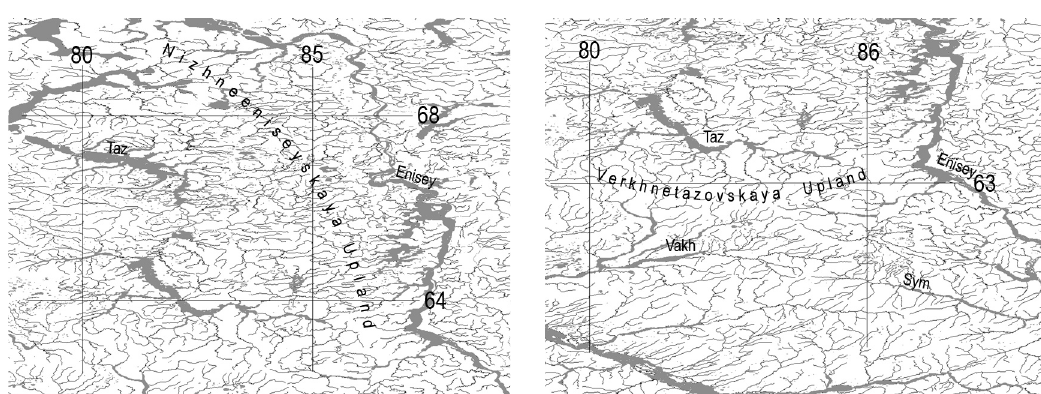
Fig. 8. Map of Hills of Nizhneeniseyskaya Upland calving grounds.